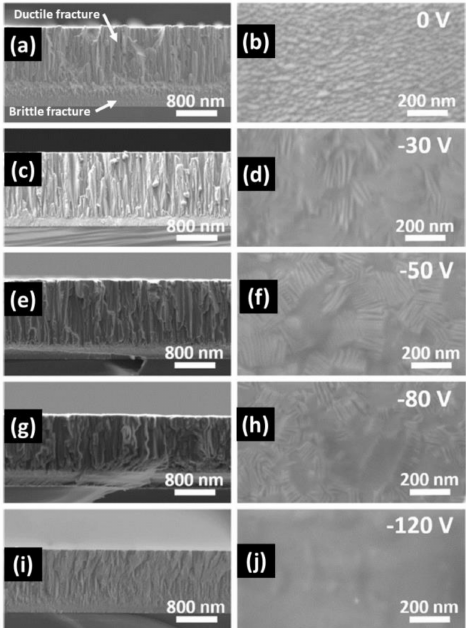
Figure 4. SEM cross-section and surface micrographs of the Ta coatings deposited by DOMS with a substrate biasing of: ( a , b ) 0 V; ( c , d ) − 30 V; ( e , f ) − 50 V; ( g , h ) − 80 V; ( i , j ) − 120